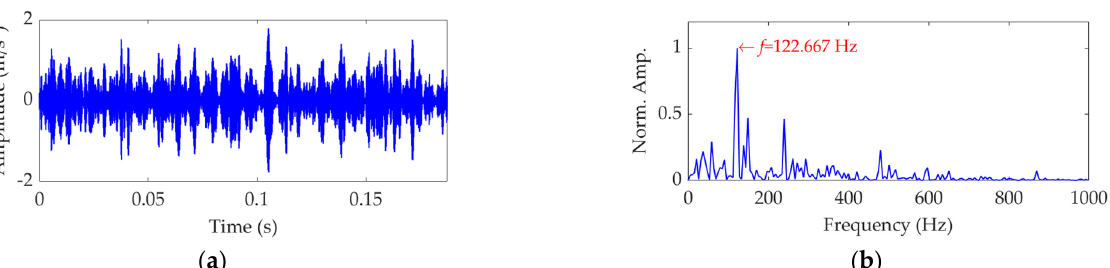
Figure 8. Results of the simulated vibration signal x ( t ) obtained by VMD.